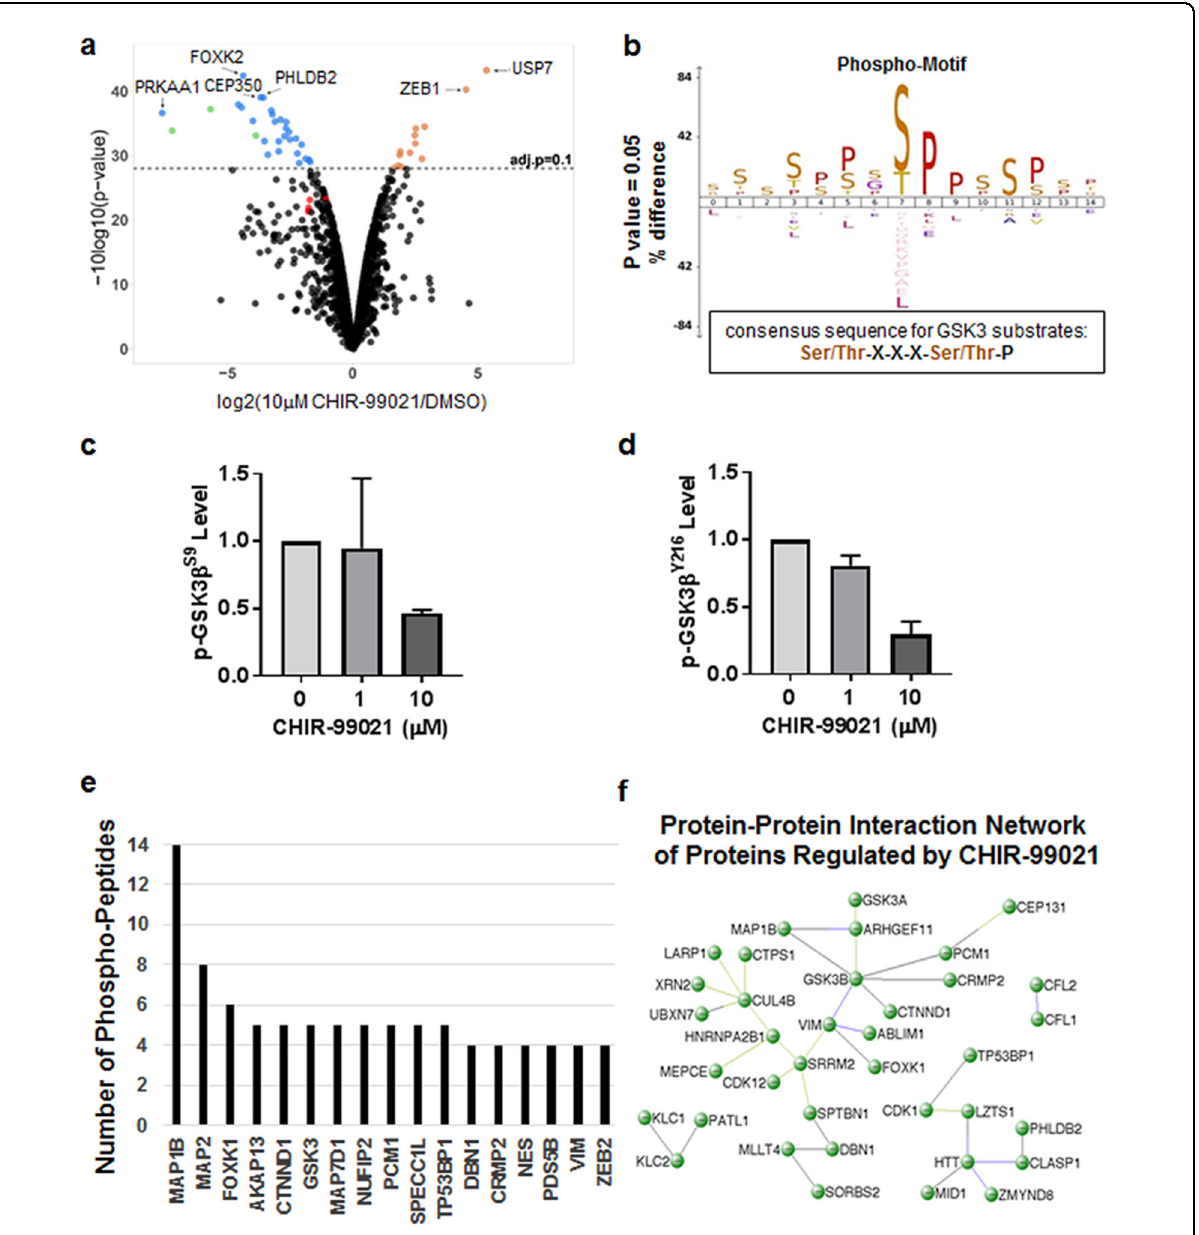
Fig. 1 Discovery of candidate GSK3 neural substrates with SILAC phosphoproteomics. a Volcano plot of phosphopeptides identi fi ed in the 10 μ m CHIR-99021 treatment. Fold changes are plotted versus the − log 10 of their P nom values. Out of 2829 phosphopeptides, 43 were signi fi cantly regulated by 10 μ M CHIR-99021 (dots above dashed line — blue and brown dots). Green dots represent phosphopeptides mapped to CRMP2 protein, while red dots to GSK3 α / β . b Phospho-motif enriched in phosphopeptides downregulated by 10 μ m CHIR-99021 (weblog.berkeley.edu). The phospho-motif matches the consensus sequence of GSK3 substrates, which is Ser/Thr-X-X-X-Ser/Thr-P where the fi rst Ser or Thr is the target residue, X is any amino acid (but often Pro), and the last Ser-P/Thr-P is the site of priming phosphorylation. c , d Graphs show the ratios of p-GSK3 β S9 ( c ) and p- GSK3 β Y216 ( d ) in CHIR-99021-treated over control. Note that the phosphopeptides for GSK3 β are shared with GSK3 α and therefore have been labeled as such in Supplemental Table 1. e Top 17 proteins most signi fi cantly altered by CHIR-99021, which are represented by at least 3 or more regulated phosphopeptides. f Protein – protein interaction network of proteins regulated by CHIR-99021, visualized using VisANT (5.0). Thirty-seven proteins that had at least one interaction with another protein formed three submodules centered around GSK3 β , HTT, and